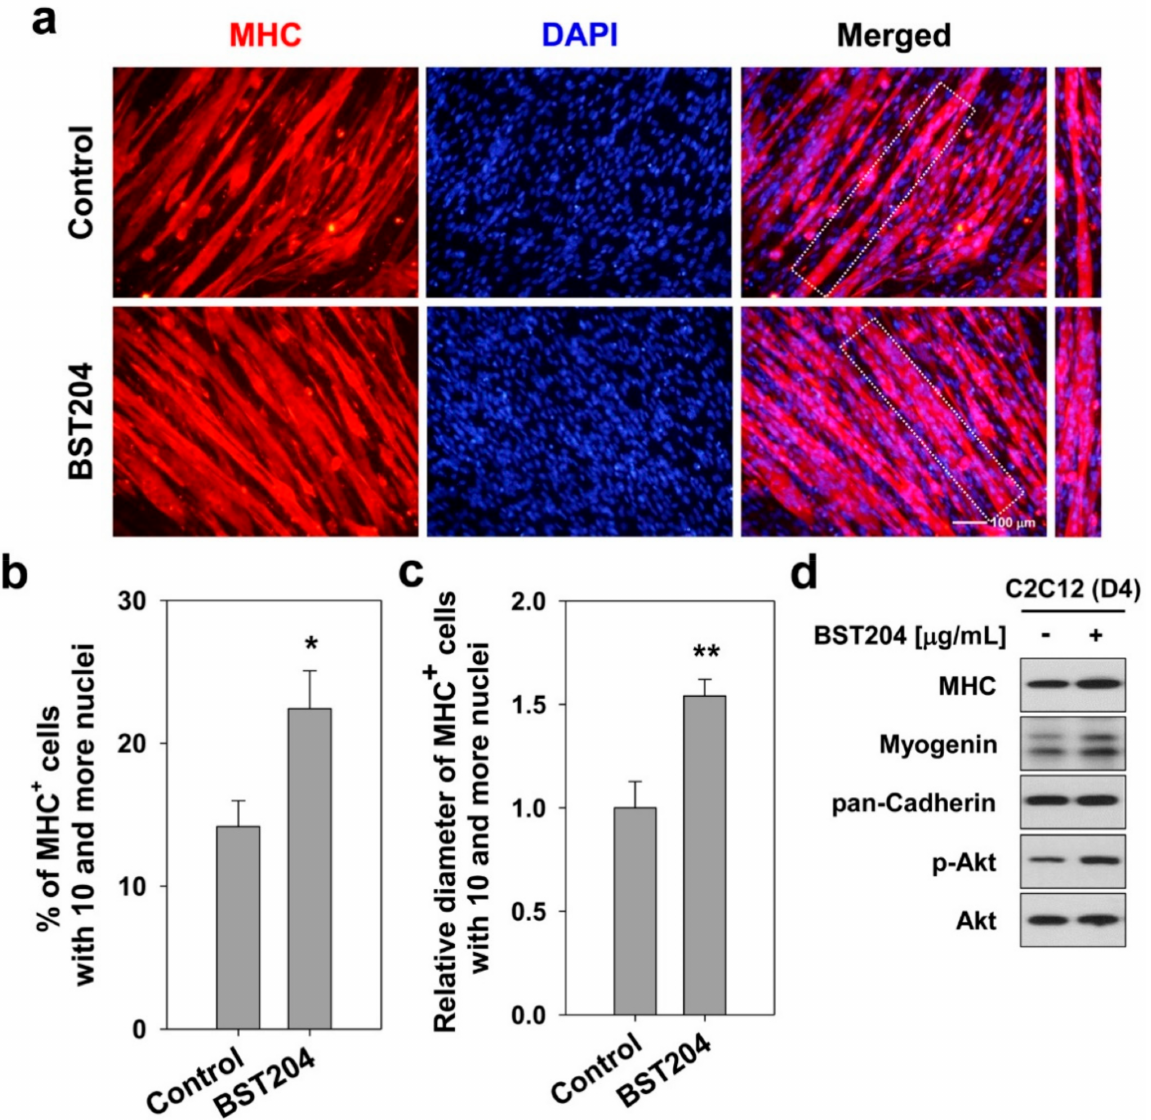
Figure 1. BST204 promotes Akt-dependent myotube hypertrophy. ( a ) C2C12 cells were induced to differentiate for 2 days in DM, and then treated with 25 µ g/mL BST204 for 2 days. These myotubes were then subjected to immunostaining for MHC expression (red) and DAPI to visualize nuclei (blue). ( b ) The MHC-positive myocytes shown in panel a were quantified as 10 or more nuclei per myotube. * p < 0.05 compared with vehicle-treated group. ( c ) Quantification of average myotube diameter from data shown in panel a . ** p < 0.01 compared with vehicle-treated group. ( d ) Cell lysates from panel a were subjected to immunoblotting analysis. This experiment was repeated twice with similar